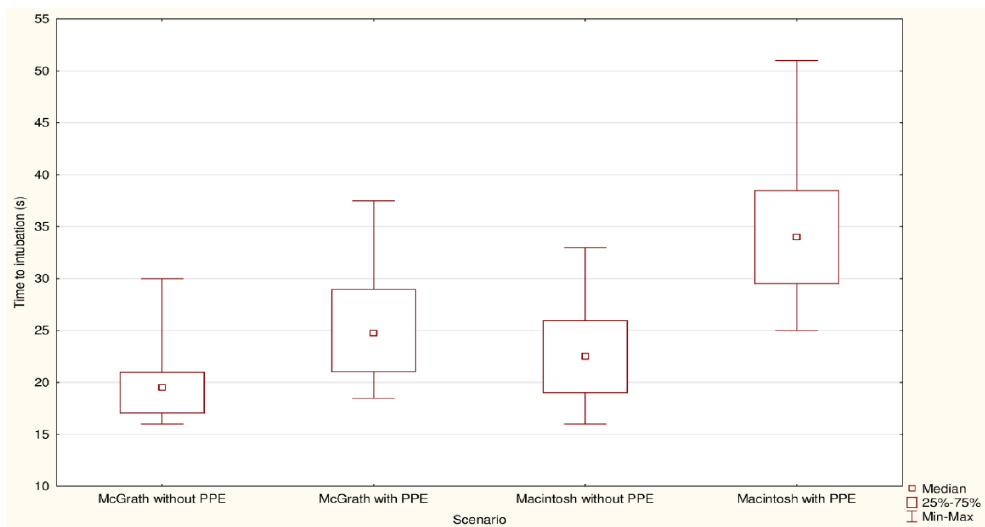
Figure 2. Median intubation times among McGrath and Macintosh laryngoscopes with and without PPE-AGP conditions.